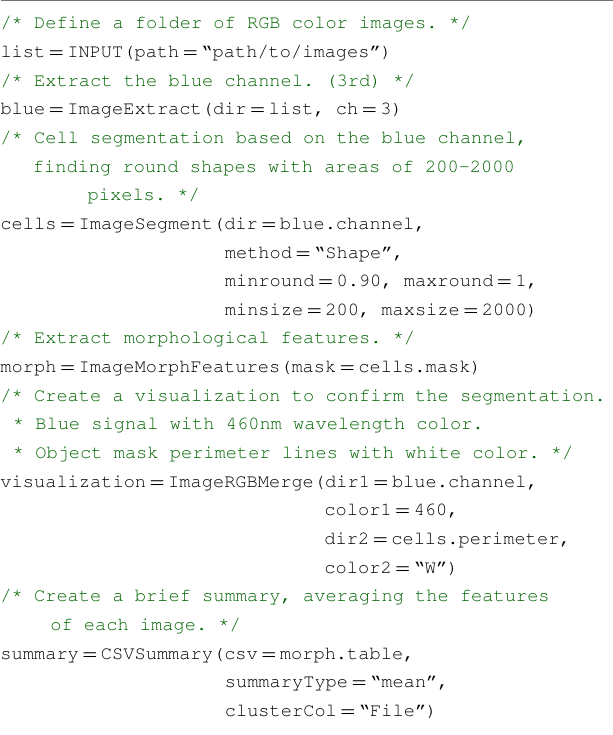
Table 2 |An example pipeline script extracting morphological features by segmenting cell nuclei